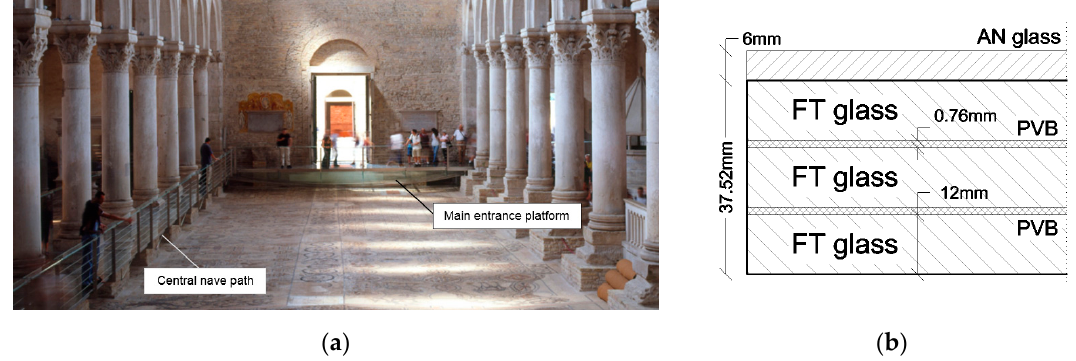
Figure 2. In-service pedestrian system object of analysis: ( a ) General / front view (photo by C. Bedon, courtesy of So.Co.Ba) and ( b ) nominal cross-section of the glass slab.